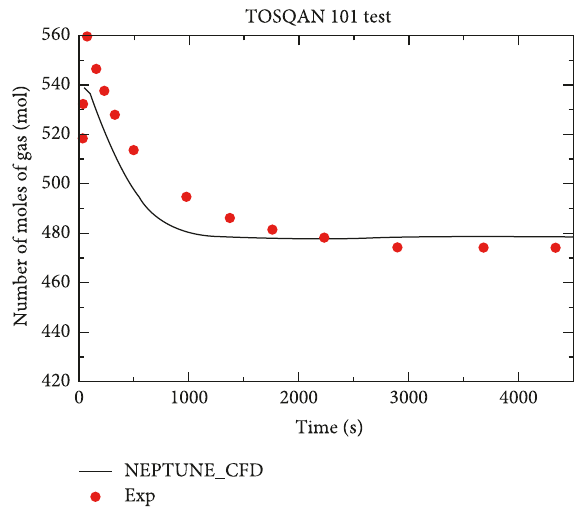
Figure 1: Number of moles of gas in TOSQAN